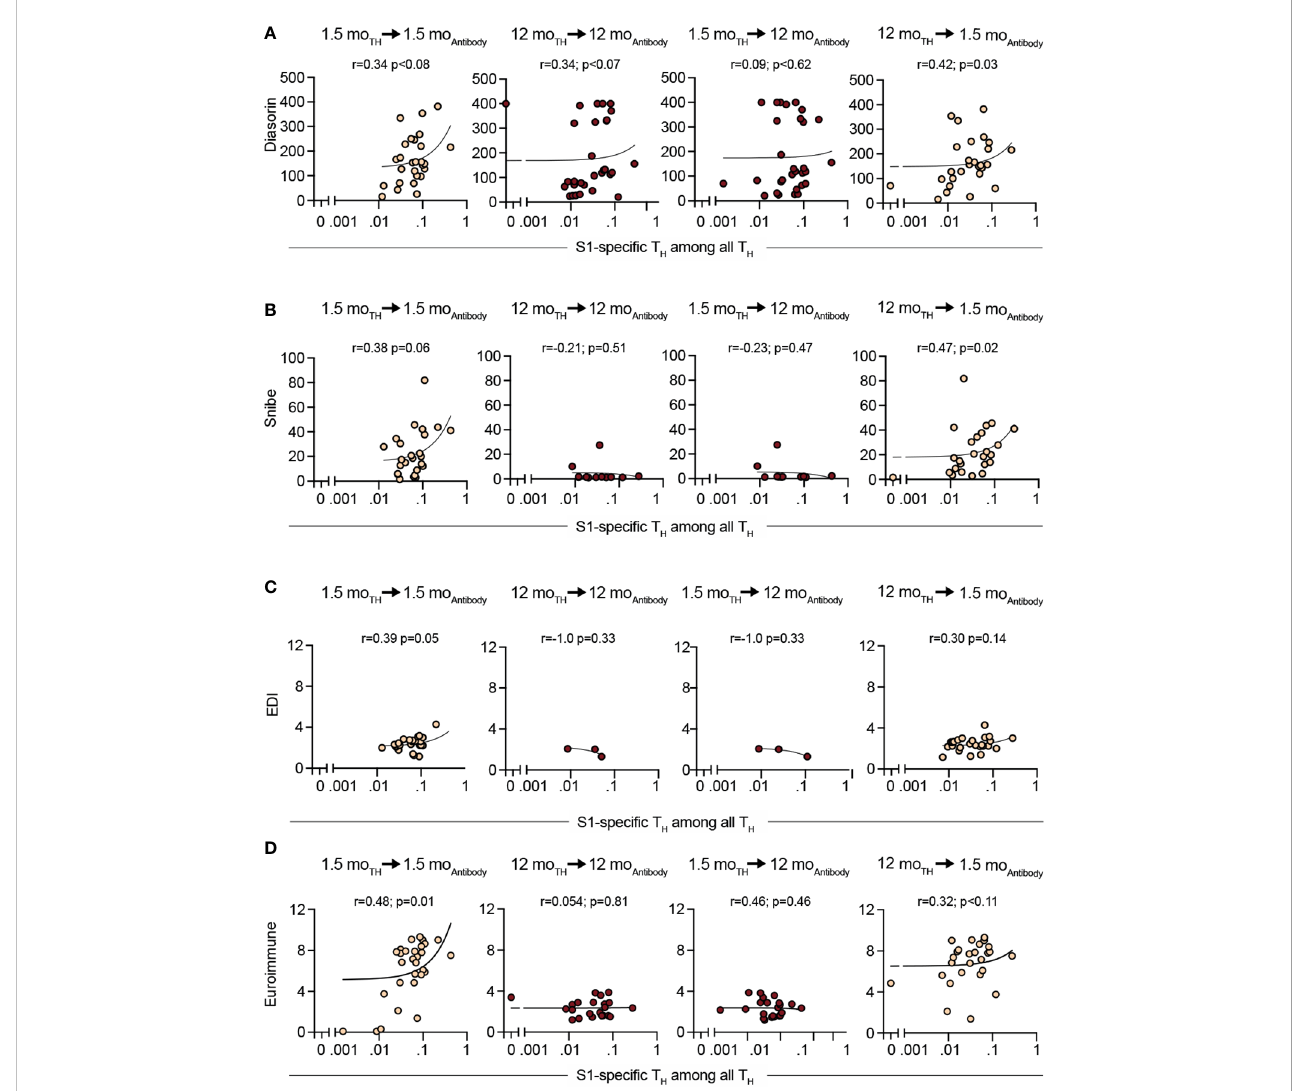
FIGURE 5 Spearman correlation analysis of SARS-CoV-2 – speci fi c T H cells (CD3 + CD4 + CD154 + 4-1BB + ) after S.Pep-1 (N) stimulation with initially (1.5 months) positive serological test only. Comparisons were the different combinations of the 1.5-month and 12-month time points after the SARS-CoV-2 outbreak in Neustadt-am-Rennsteig. (A) Liaison SARS-CoV-2 S1/S2 IgG CLIA DiaSorin, (B) Maglumi 2019-nCoV IgG CLIA Snibe , (C) EDI Novel Coronavirus COVID- 19 IgG ELISA and (D) Euroimmune anti – SARS-CoV-2-ELISA (IgG). mo, month; T H , T helper cells (CD3 + CD4 + ). Dots indicate individual participants. Orange, 1.5-month antibody data; Dark red, 12-month antibody